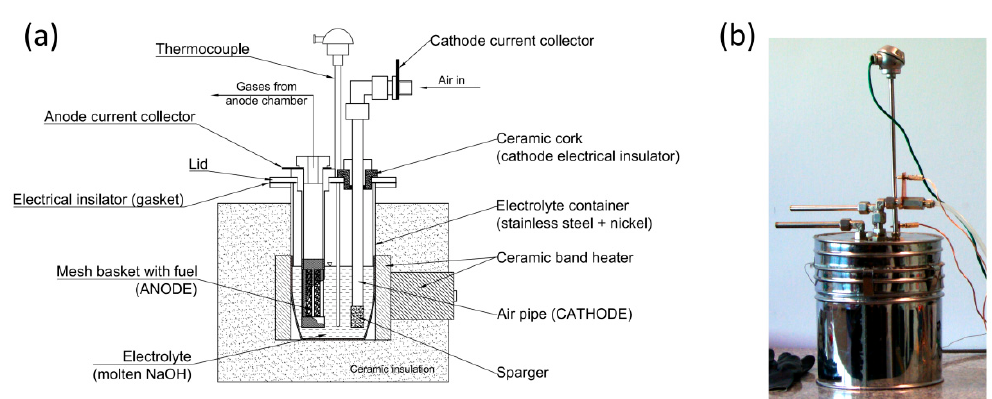
Figure 3. Design scheme ( a ) and photograph ( b ) of experimental model II of MH-DCFC made of stainless steel AISI 300 series.